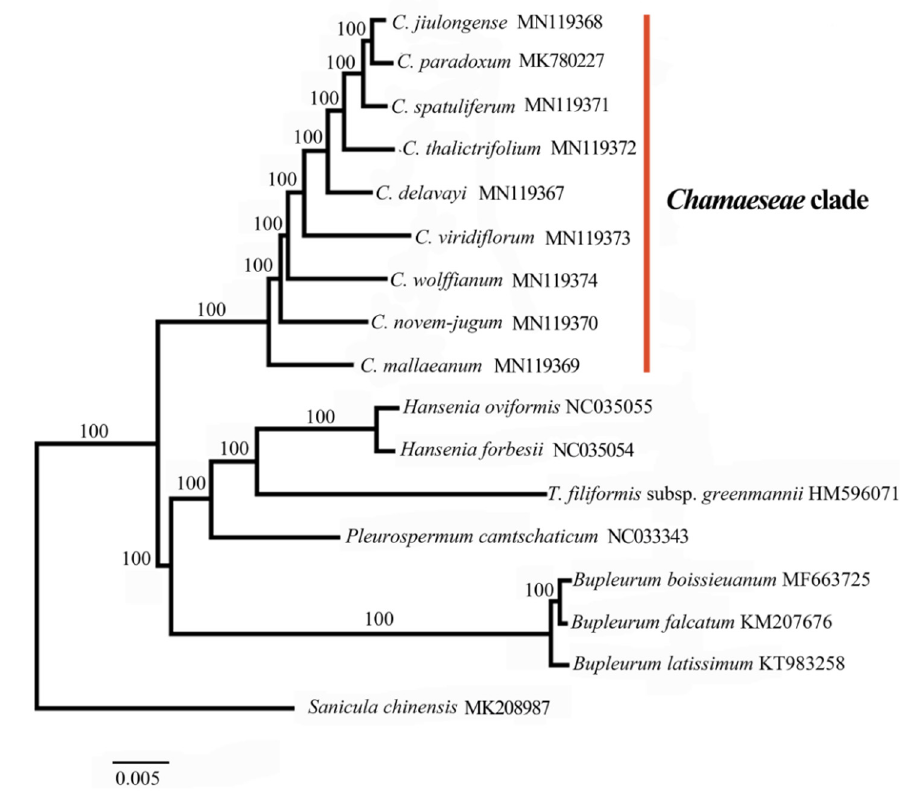
Figure 7. Phylogenetic relationships of Chamaesium species with related species based on the whole plastid genomes by maximum likelihood (ML) with bootstrap values above the branches.